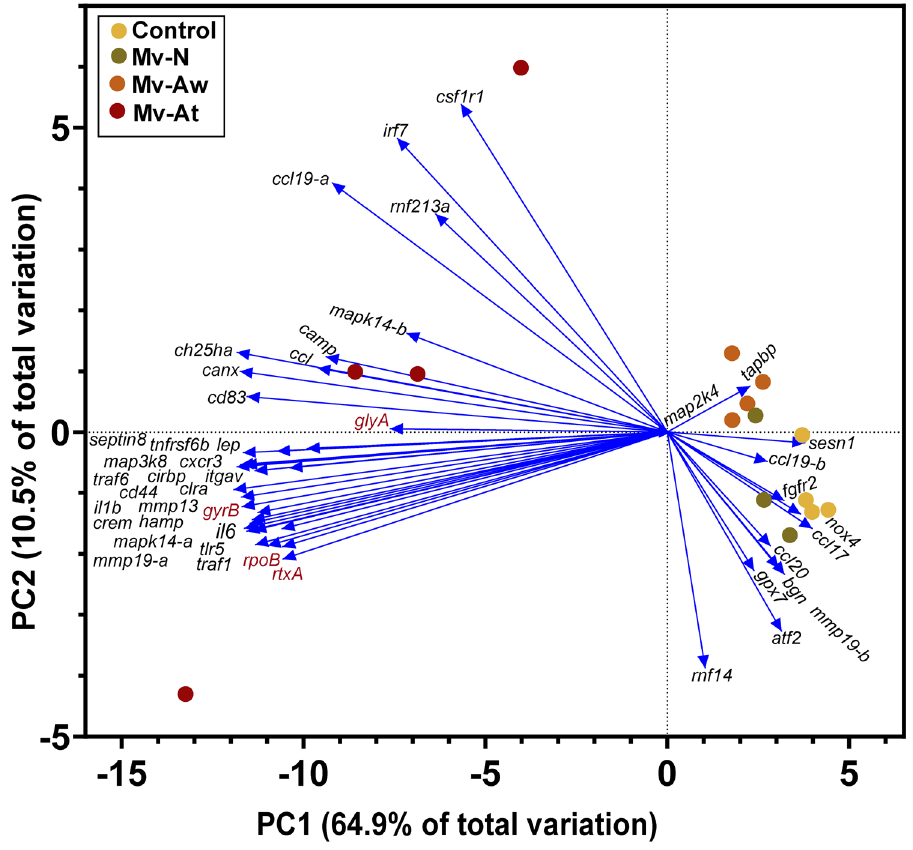
Figure 6. Principal Component Analysis (PCA) using all qPCR-studied transcripts for Atlantic salmon and M. viscosa . The skin samples of M. viscosa -infected Atlantic salmon at the lesion (Mv-At; n = 4) and away (Mv-Aw; n = 4) sites, as well as the samples of fish with no lesion in M. viscosa group (Mv-N; n = 3) and non-infected control group (Control; n = 4), were used for qPCR. Atlantic salmon and M. viscosa transcripts are shown in black and red,